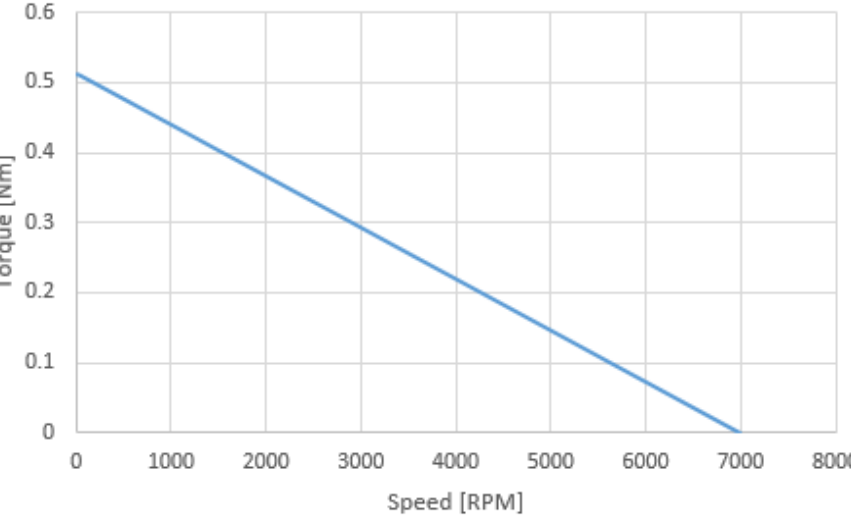
Figure 2. Torque vs. speed characteristic of a DC motor used in pump applications.